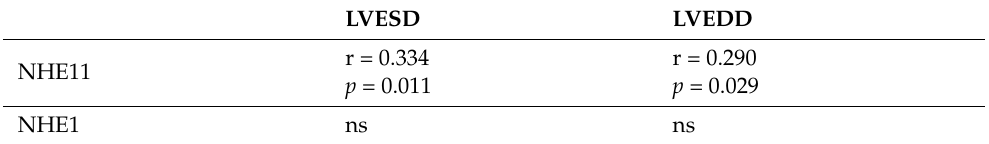
Table 2. Relationships between NHEs protein levels and ventricular parameters. LVESD LVEDD r = 0.334 r = 0.290 NHE11 p = 0.011 p = 0.029 NHE1 ns ns LVESD, left ventricular end-systolic diameter; LVEDD, left ventricular end-diastolic diameter; ns, not significant.